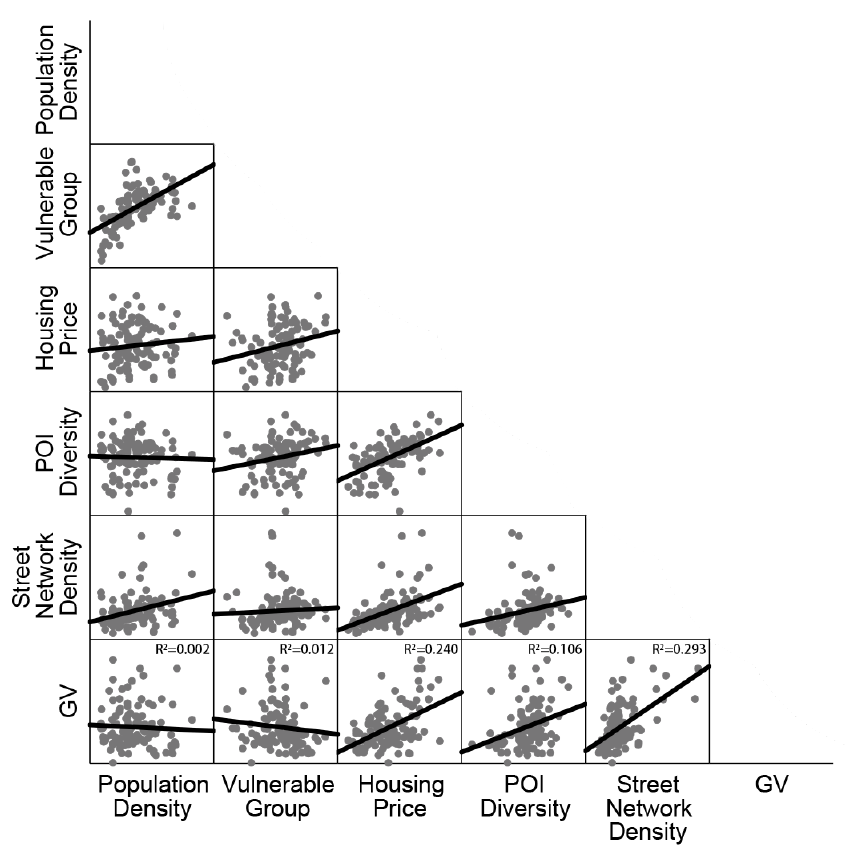
Figure 11. Correlation between GVI and other variables. Table 4. Correlation analysis of green view.